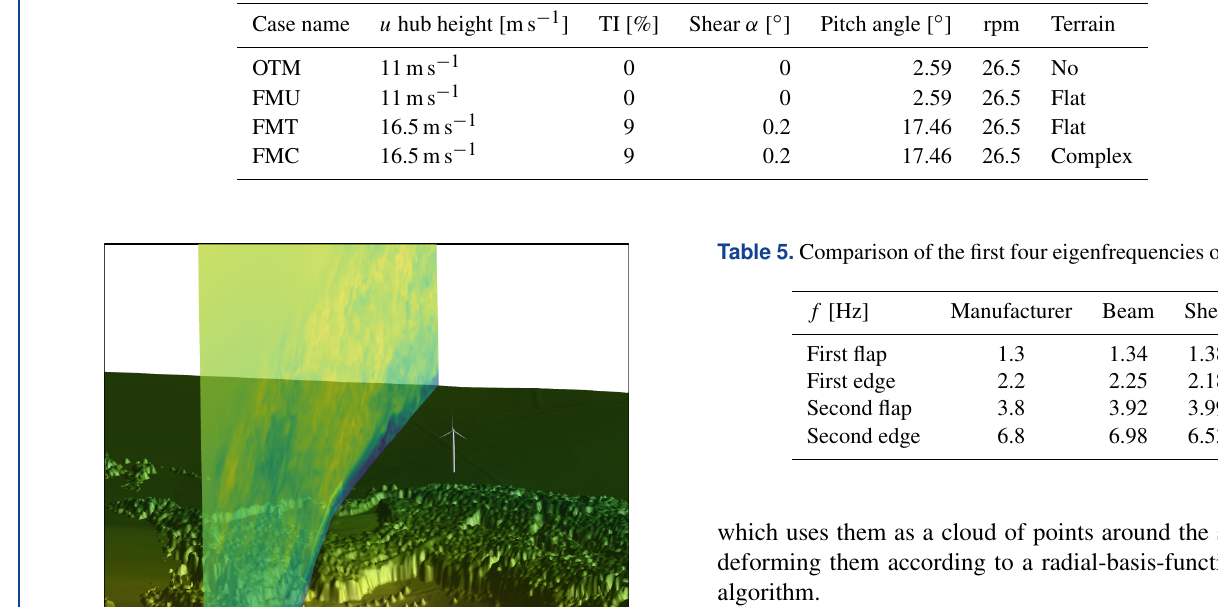
Table 3. Setup of the computed cases (effective conditions at the turbine position).